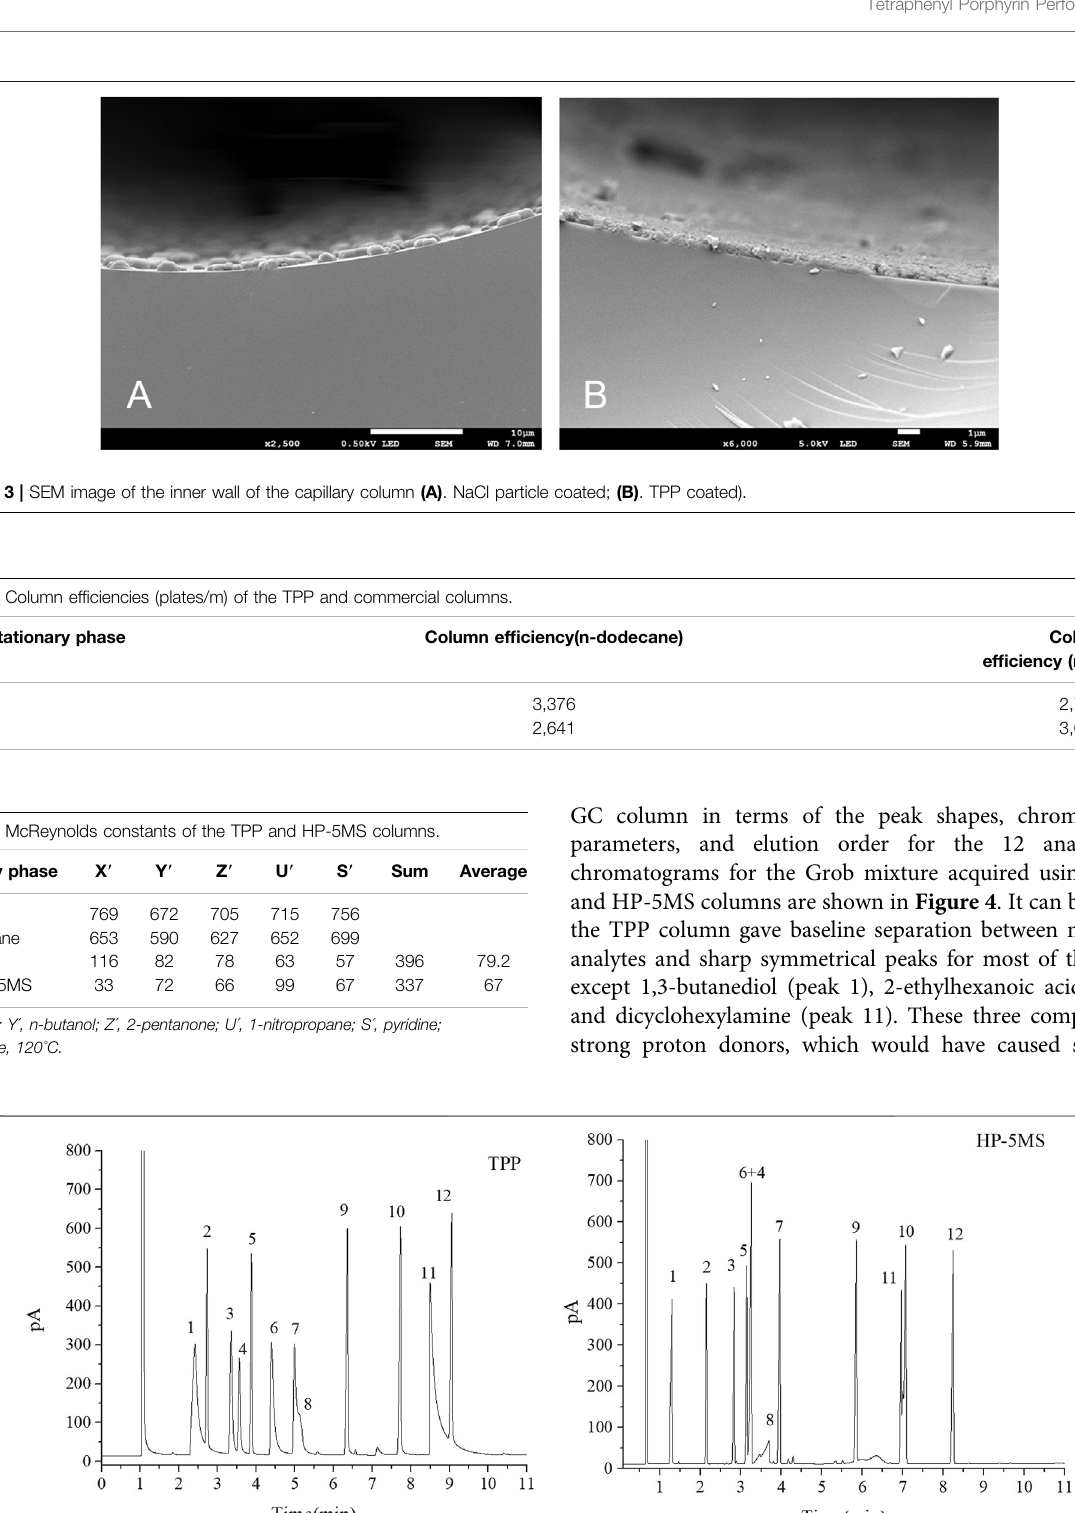
FIGURE 4 | GC separation of the Grob mixture on the TPP and HP-5MS columns. Peaks:(1) 1,3-butanediol, (2) n-decane, (3) n-octanol, (4) n-nonanal, (5) n-undecane,(6)2,6-dimethylphenol,(7)2,6-dimethylaniline,(8)2-ethylhexanoicacid,(9)methyldecanoate,(10)methylundecanoate,(11)dicyclohexylamine,(12)methyl dodecanoate. Temperature program: 80 ° C (1 min) to 160 ° C at 10 ° C min − 1 .